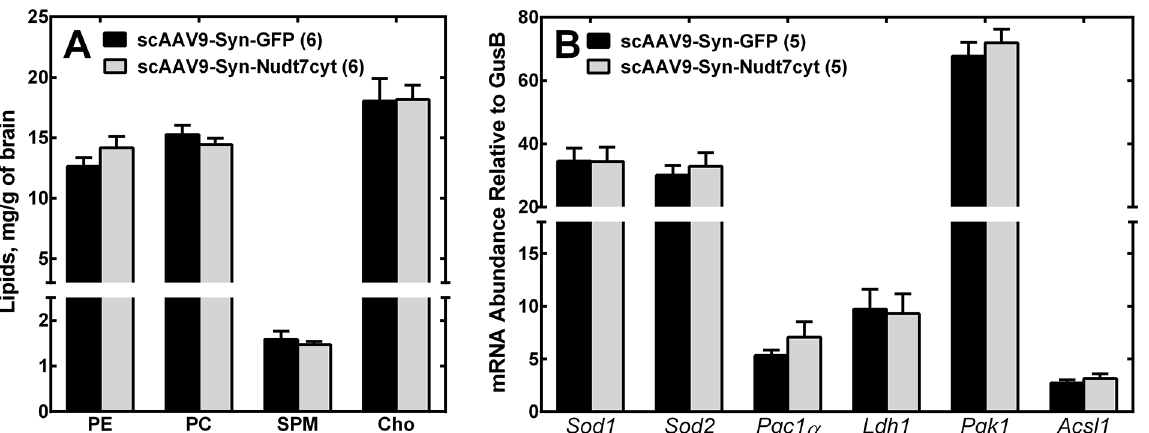
Fig 5. Brain lipid and RT-PCR analyses. Brains from 17 week-old mice were analyzed for (A) lipid composition and (B) transcript levels of selected genes involved in mitochondrial function, metabolism and response to oxidative stress. Abbreviations used are: PE, phosphatidylethanolamine; PC, phosphatidylcholine; SPM, sphingomyelin; Cho, cholesterol. Transcripts were measured for the following genes: Sod1 and Sod2 , superoxide dismutase 1 and 2; Pgc1 α , peroxisome proliferative activated receptor, gamma, coactivator 1 alpha; Ldh1 , lactate dehydrogenase 1; Pgk1 , phosphoglycerate kinase 1; Acsl1 , acyl-CoA synthetase long-chain family member 1. Numbers in parentheses indicate the number of animals used for the measurements. Data are reported as the mean ± the standard